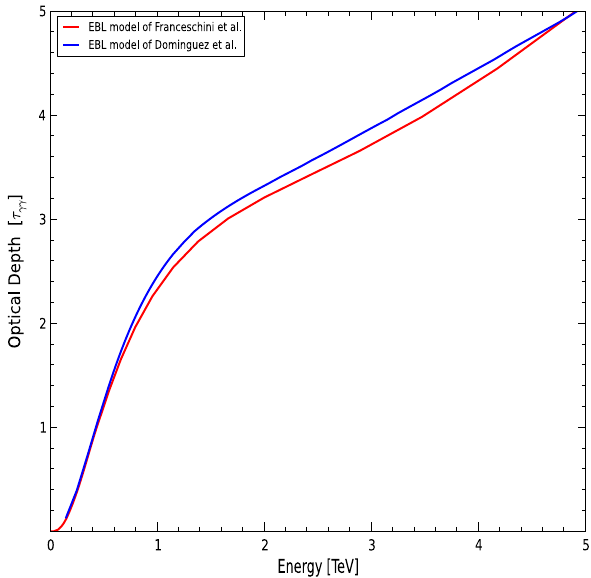
Fig. 1 At a redshift of z = 0 . 212, the optical depths τ γγ in the EBL models of Domínguez et al. and Franceschini et al. are shown for com- parison with the background photons in the jet. So a better under- standing of the emission mechanisms in the jet is